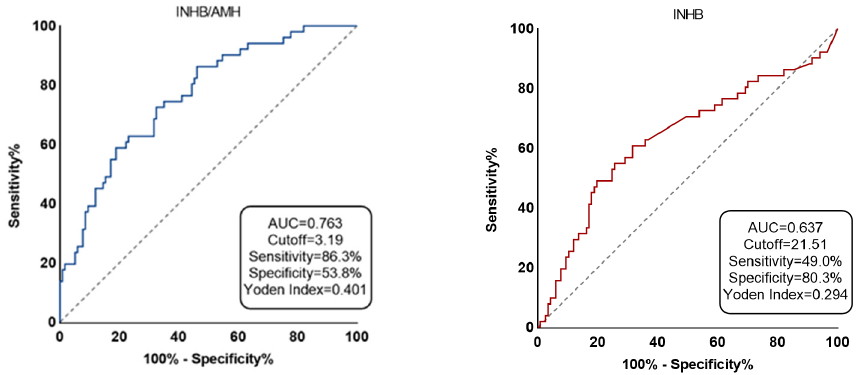
Figure 2. The two predictors’ accuracy is displayed by receiver-operating characteristic (ROC) curve.